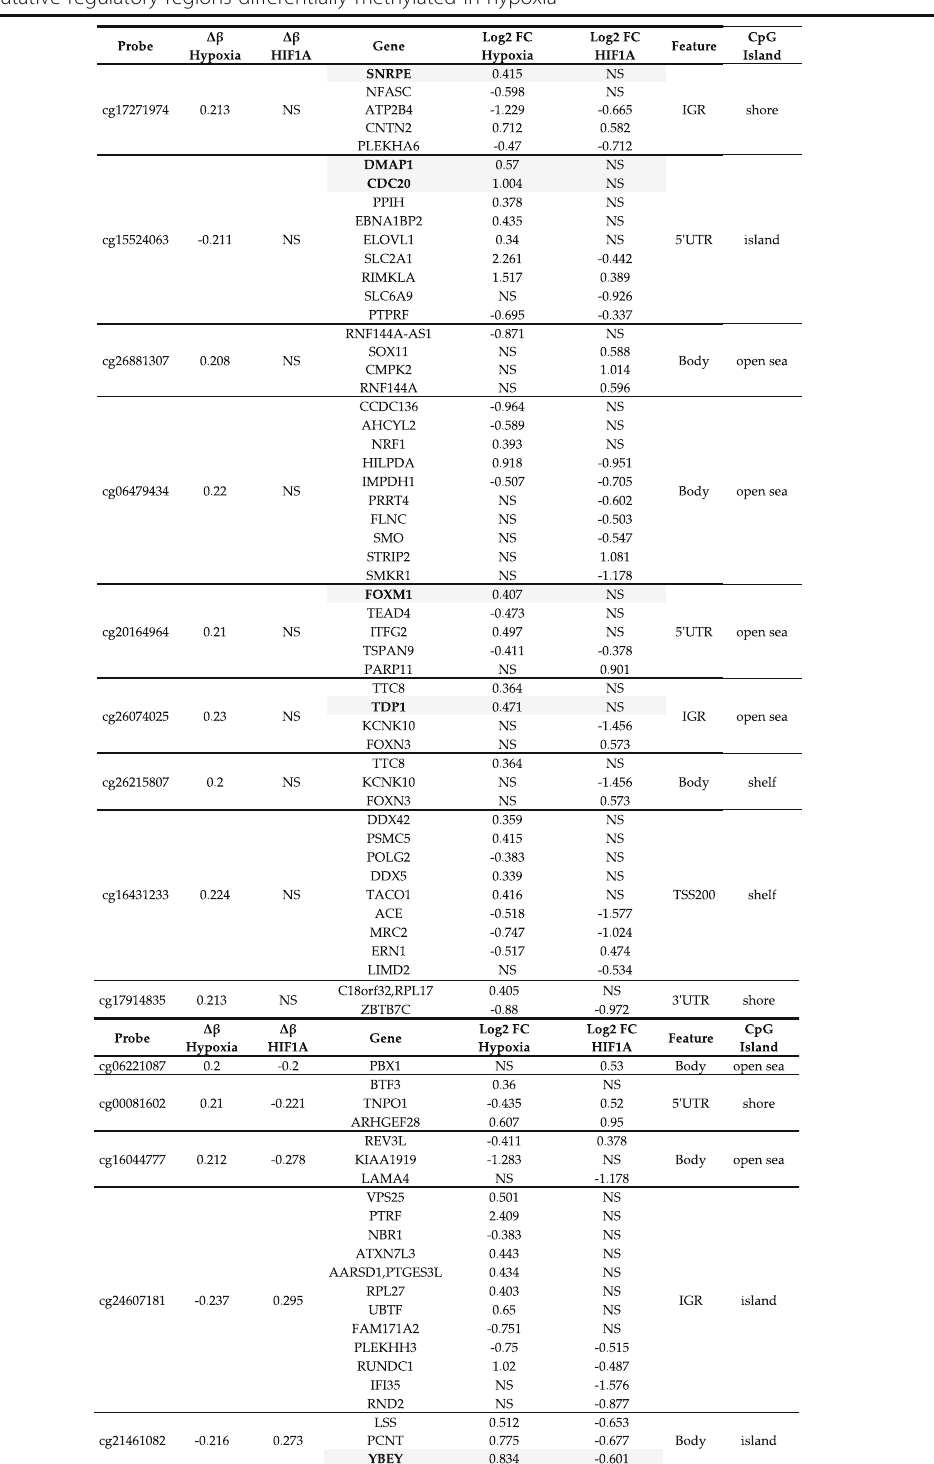
Table 2 List of putative regulatory regions differentially methylated in